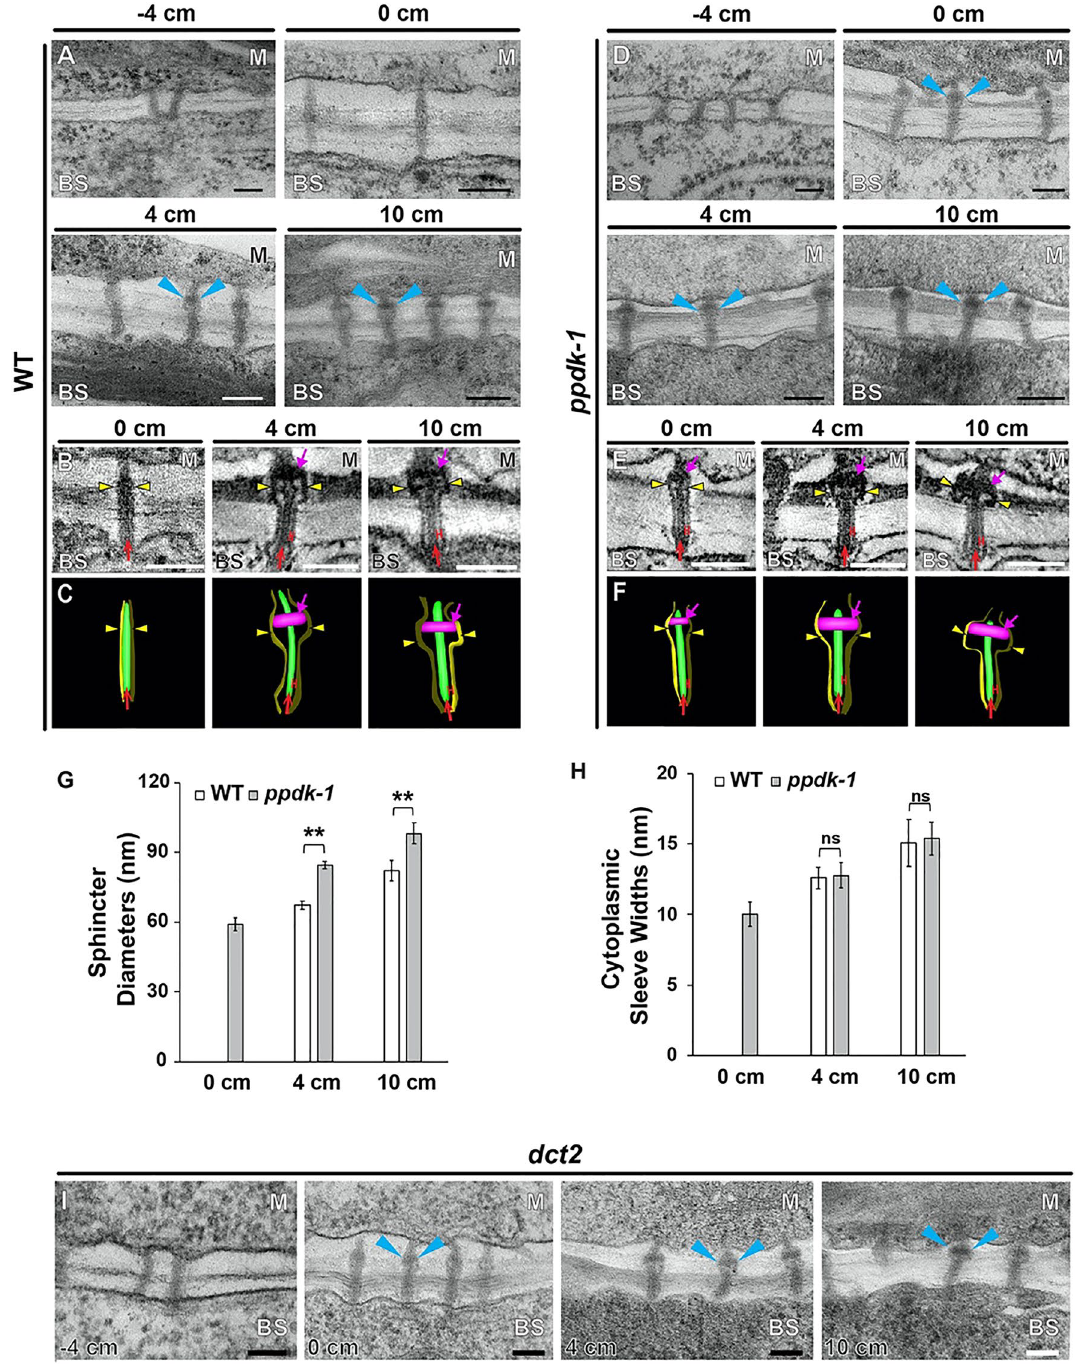
Figure 4. Ultrastructure of PD connecting M and BS cells. (A) TEM micrographs of PD at the M-BS interface in wild-type B73 (WT) leaves. PD sphincters are marked with arrowheads. Scale bars, 100 nm. (B,C) PD and the plasma membrane at the M-BS interface as observed in ( B ) ET slice images and ( C ) 3D models. Sphincters, desmotubules, plasma membrane, and cytoplasmic sleeves are marked with magenta arrows, red arrows, yellow arrowheads, and red “H”s respectively. Scale bars, 150 nm. (D–F) TEM micrographs of PD at the M-BS interface in ( D ) ppdk-1 leaves, ( E ) ET slice images, and ( F ) 3D models. Sphincters, desmotubules, plasma membrane, and cytoplasmic sleeves are marked with magenta arrows, red arrows, yellow arrowheads, and red “H”s respectively. ( G,H ) Morphometric comparisons of PD at the M-BS interface in WT (white bars) and ppdk-1 (gray bars) leaves. (G) Sphincter diameters and (H) cytoplasmic sleeve widths were measured from tomograms at the three stages. Approximately 20 PD from three different plants were examined for each genotype and each stage. Error bars depict SDs ( ** , p < 0.01; ns: not significant; Student’s t-test). (I) TEM micrographs of PD at the M-BS interface in dct2 leaves. PD sphincters were discerned in 0-cm sections from the ppdk-1 and dct2 mutant leaves. Sphincters are indicated by